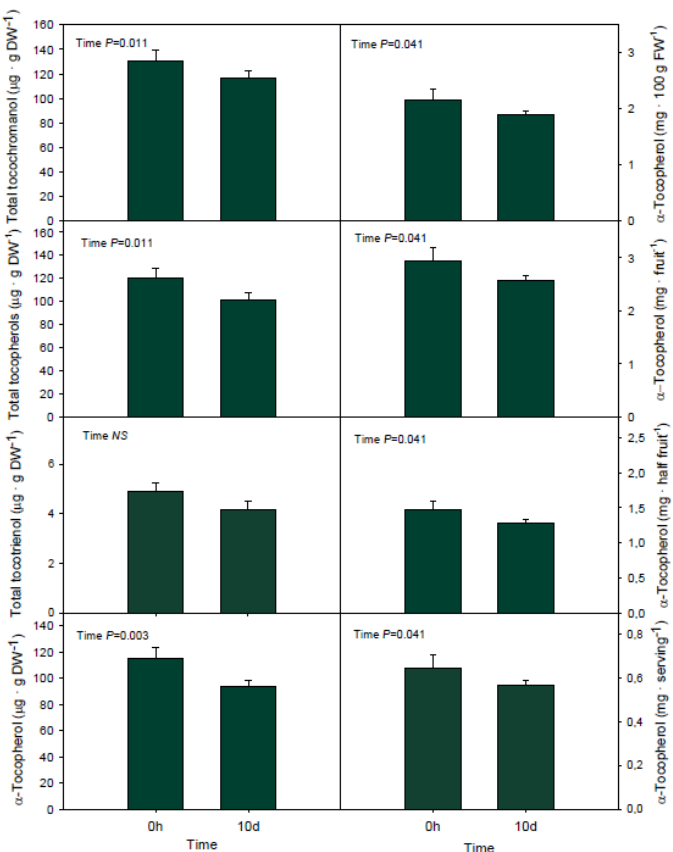
Figure 4. Influence of long-term (10 d) storage of Bacon avocados at cold temperatures (4 ◦ C) in the contents of total tocochromanols, tocopherols, tocotrienols and α -tocoperol. Contents of α -tocopherol are also shown in mg per 100 g of mesocarp in fresh weight (FW), per one fruit (136 g FW), per a half (68 g FW) and per serving according to the Nutrition Labelling and Education Act (NLEA; corresponding to 30 g FW). Data represent the mean ± standard error of n = 18 fruits. Di ff erences were considered significant when p < 0.05. DW, dry weight.